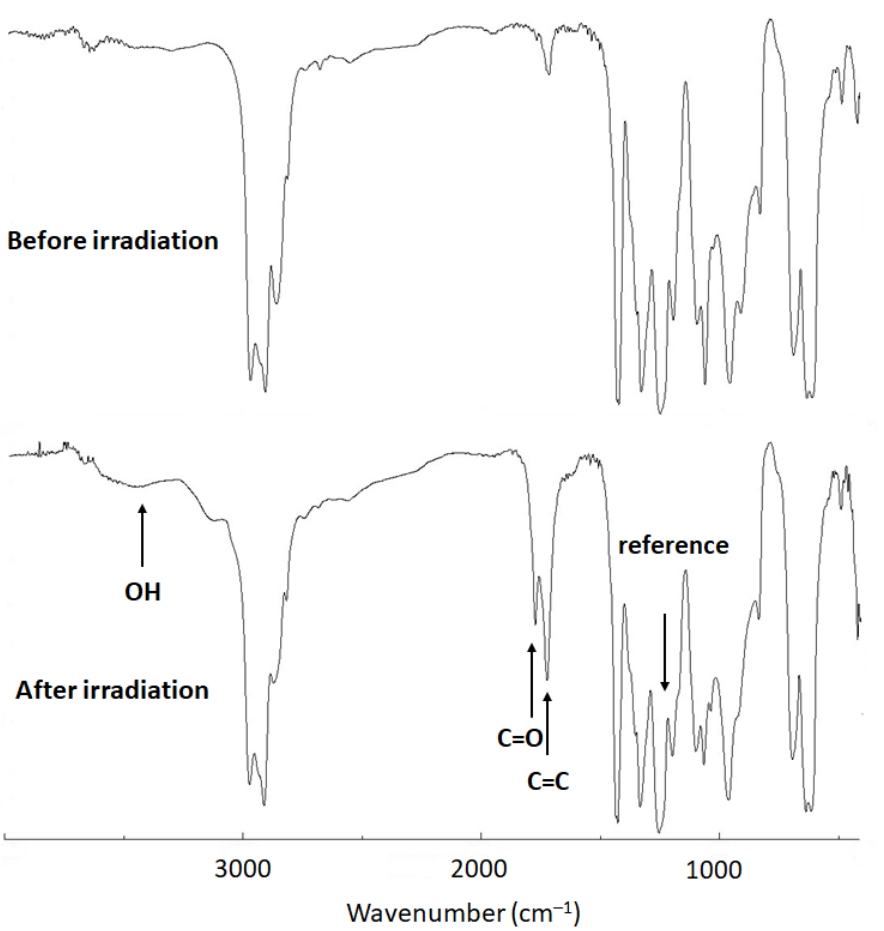
Figure 2. IR spectra of pure PVC film before and after irradiation.